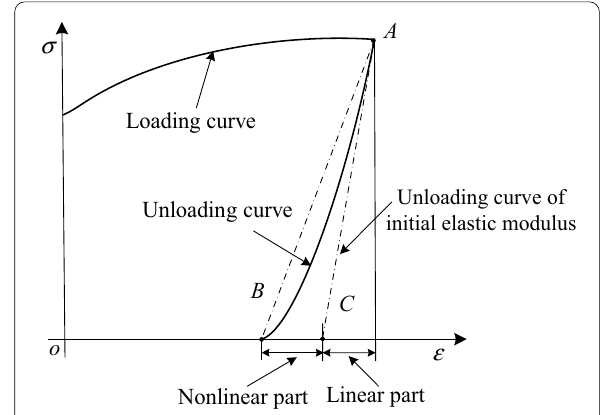
Figure 5 Stress and stain curve in unloading